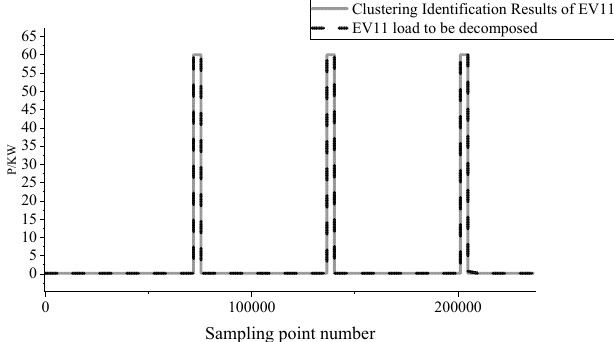
Figure 13. EV11 data identified by clustering.